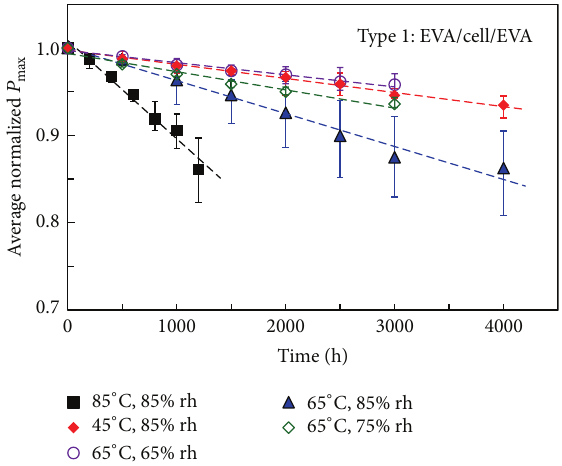
Figure 2: Average normalized 𝑃 max of Type 1 as a function of